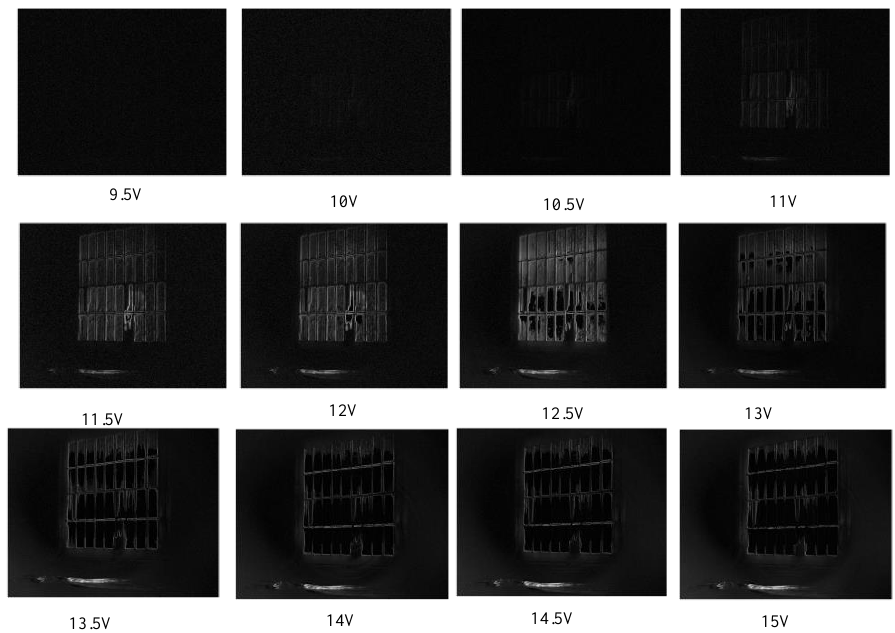
Figure 9. Images DOP of polycrystalline silicon photovoltaic panel with different bias voltages.